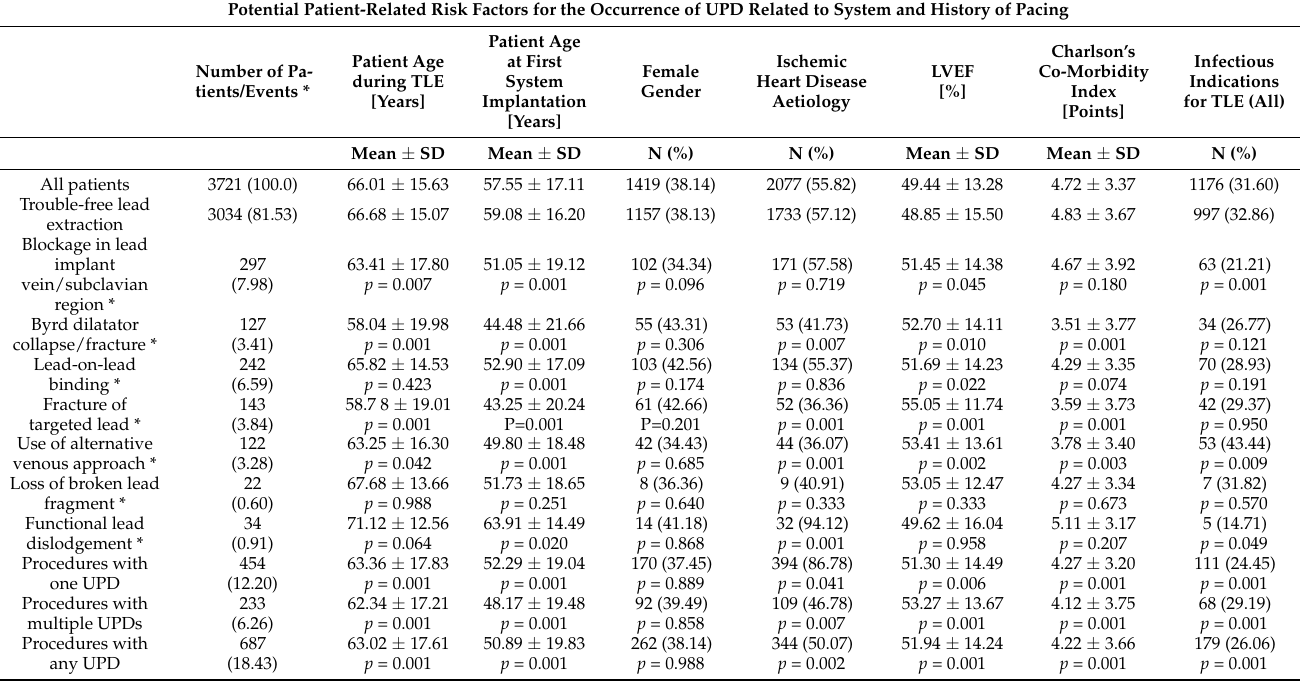
Table 2. Potential patient-related risk factors for the occurrence of unexpected procedure